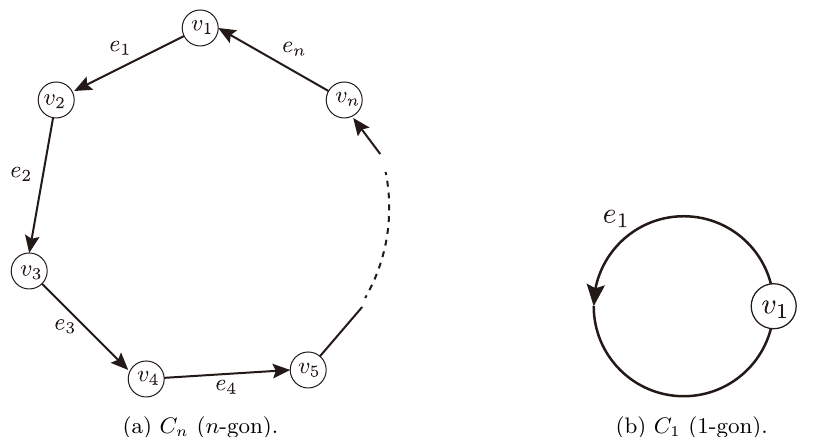
Figure 2. A cycle graph C n has n vertices and edges. This is also called ˆ A n − 1 quiver chain. (b) is a simplest case of C 1 (1-gon). Z C